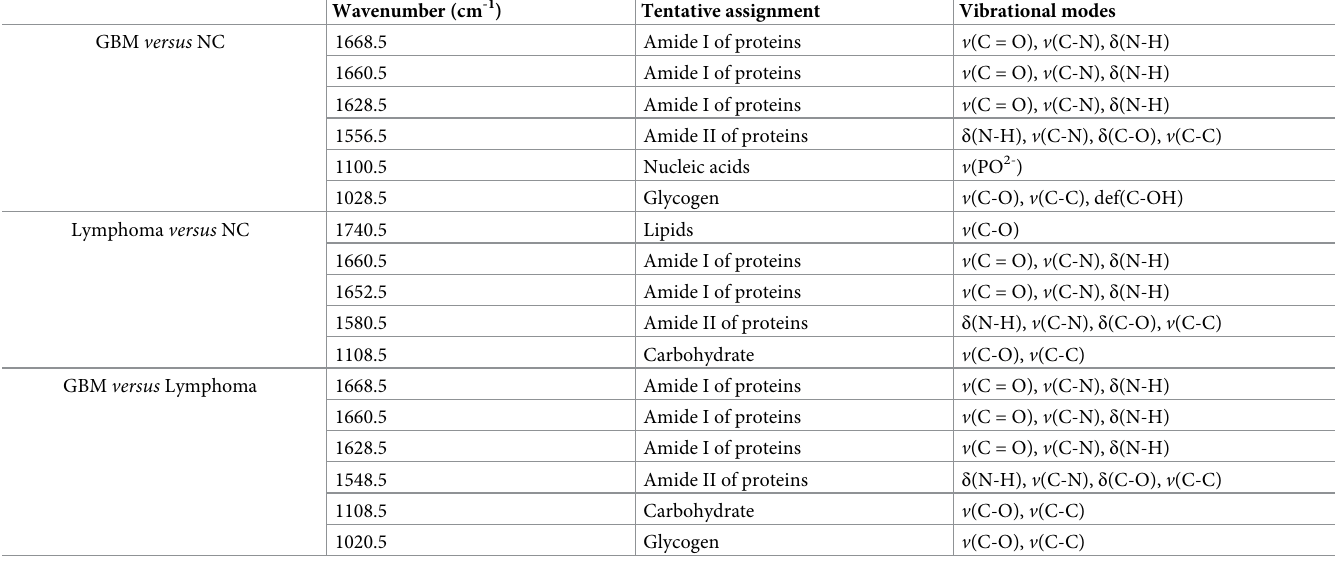
Table 4. Top wavenumbers for each group in unfiltered serum classifications. Tentative biochemical assignments and their corresponding vibrational modes are included